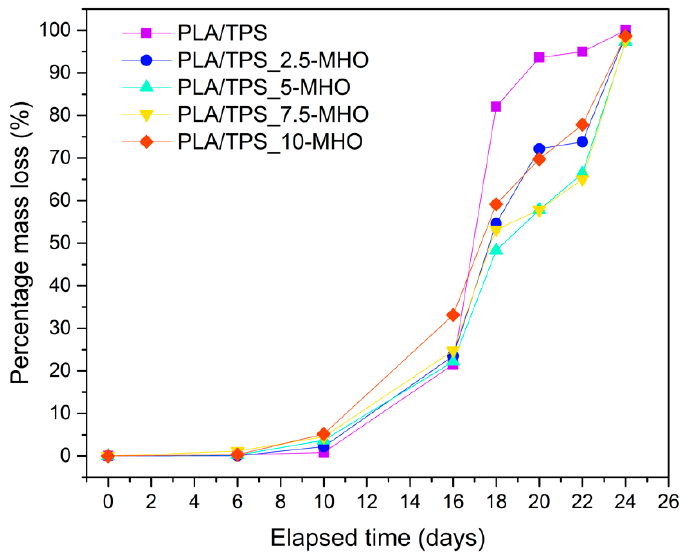
Figure 8. Weight loss recorded during disintegration test under composting conditions of PLA/TPS blend unplasticized and plasticized with different amounts of MHO content.